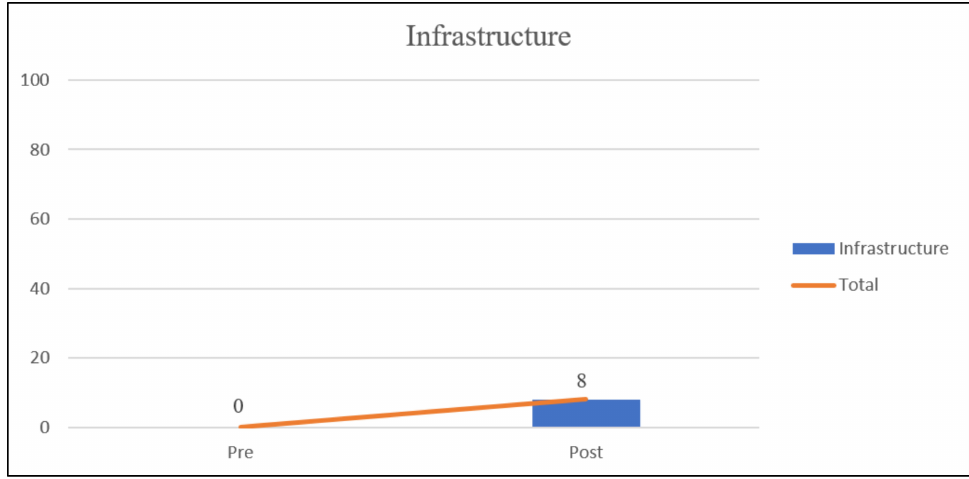
Figure 14. Infrastructure services applying